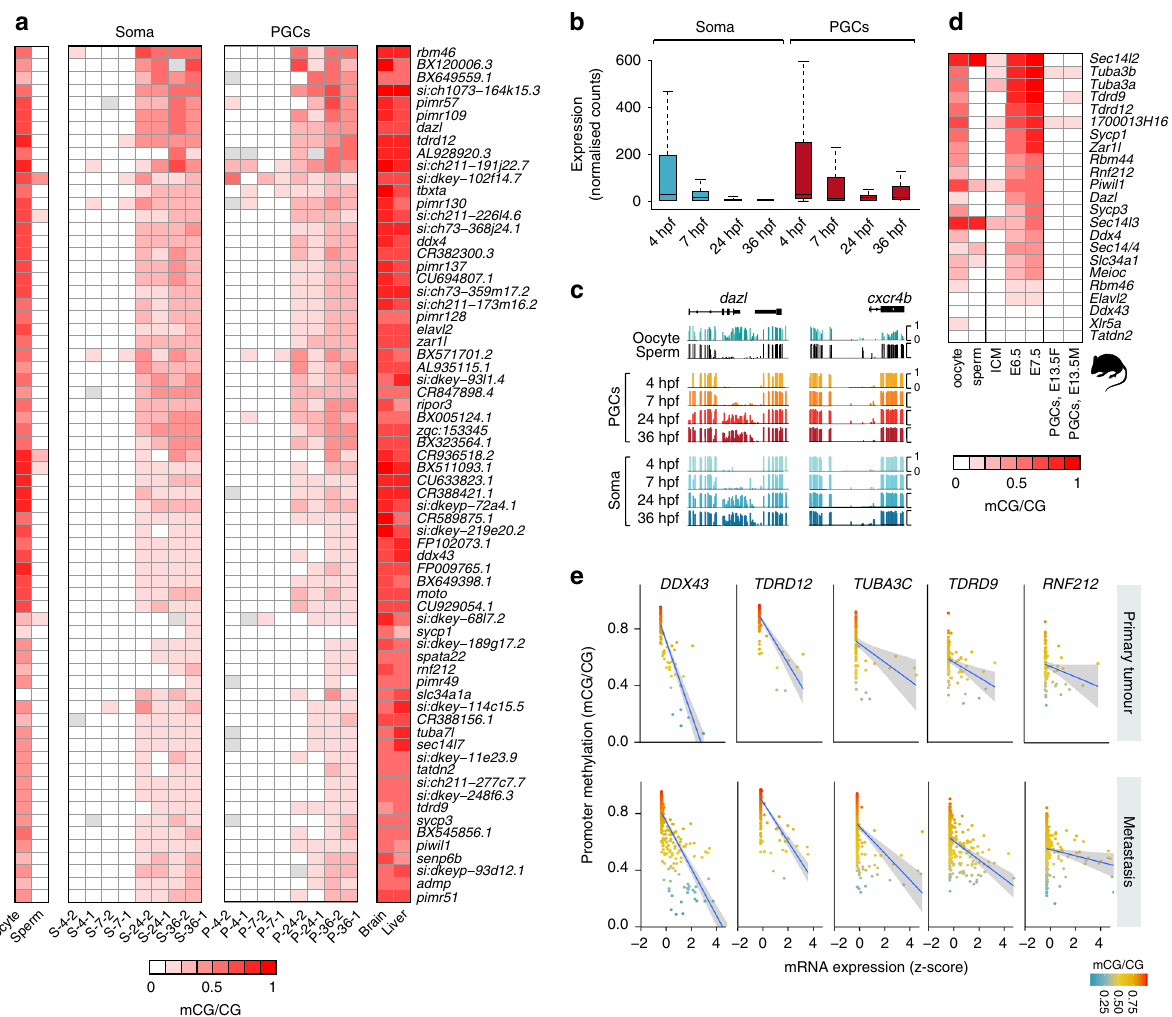
Fig. 5 Embryonic 5-methylcytosine (5mC) targeting of germline gene promoters. a Heatmap of 5mC in promoter-associated CpG islands (Bio-CAP) targeted by 5mC during zebra fi sh embryogenesis. The status of gene promoter 5mC is shown in adult germ cells (oocyte, sperm), embryonic somatic cells and primordial germ cells (PGCs), as well as in adult somatic tissues (brain, liver). b Boxplots showing expression dynamics of genes whose promoters are targeted by 5mC during embryogenesis in PGCs and soma. The boxes show the interquartile range (IQR) around the median. The upper and lower whiskers extend from the hinge to the largest and smallest value, respectively, no further than 1.5 IQR. c Browser tracks showing developmental 5mC pro fi les at dazl and cxcr4b promoters. d Heatmap of 5mC at promoter-associated CpG islands (Bio-CAP) in mouse adult germ cells (oocyte, sperm), early embryos (intracellular cell mass (ICM), E6.5, E7.5) and developing PGCs. e Scatter plots of mean promoter 5mC values (methylation β values — 450 K beadChIP arrays) and expression ( z -scores, RNA-seq V2 RSEM) of the corresponding genes in The Cancer Genome Atlas-skin cutaneous melanoma (TCGA-SKCM) patient samples (primary tumour and metastasis). The lines represent a linear regression model, whereas the shaded areas represent the extent of standard error